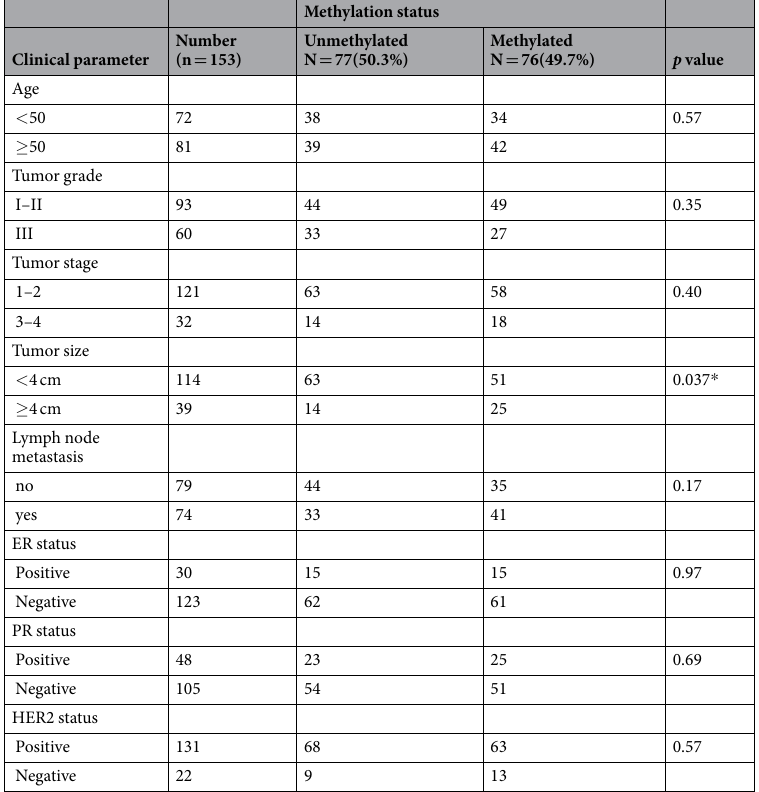
Table 1. The association of DACT2 methylation status and clinical factors in human breast cancer patients. * P values are obtained from χ 2 test, significant difference, * P <